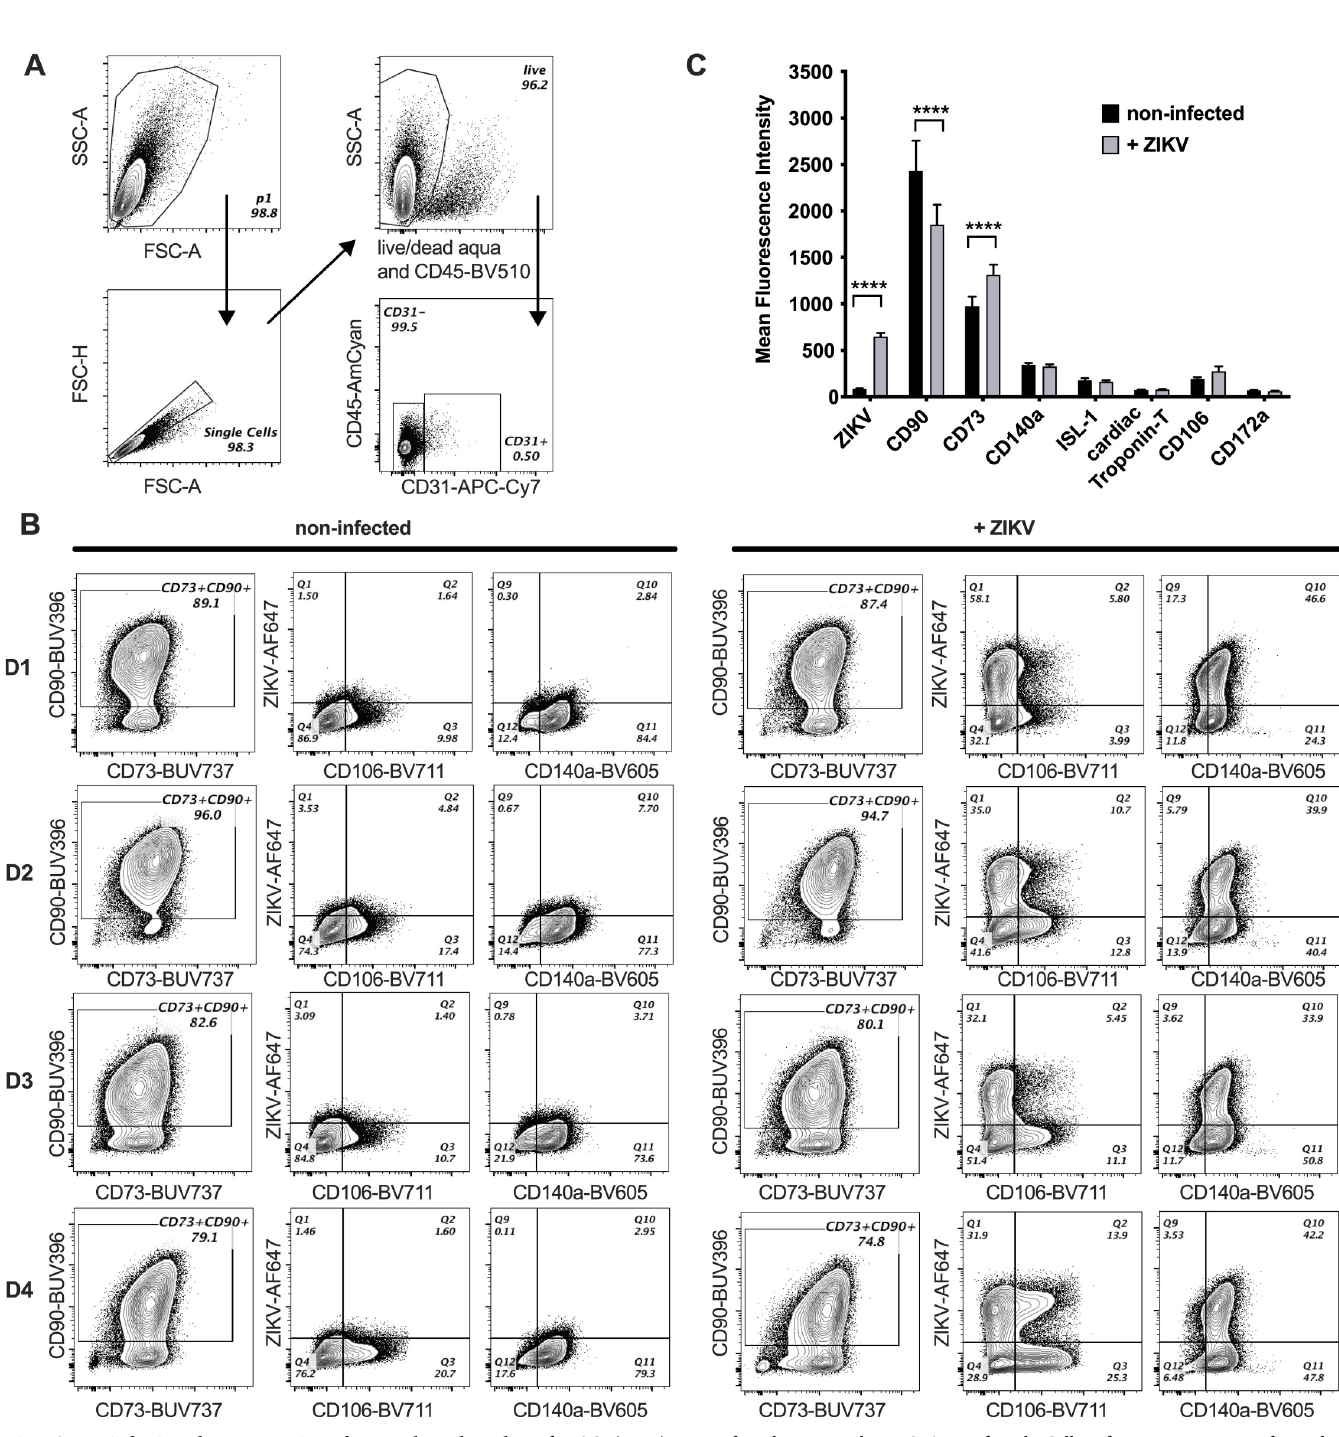
Fig 2. ZIKV infection alters expression of mesenchymal markers. fcMSCs (n = 4) were infected or not with 1 MOI ZIKV for 6 h. Cell surface staining was performed 48 h post-infection using antibodies against CD31, CD45, CD73, CD90, CD106, CD140a and CD172a; and intracellular staining with 4G2 antibody (for ZIKV detection), ISL-1, and cardiac Troponin-T. (A) fcMSCs were selected for their size (FSC vs SSC), viability, and subsequently CD45 − CD31 − cells were used to assess expression of selected markers. (B) Flow cytometry assessment of indicated markers expression, with and without ZIKV infection. Mean MFI of all markers for all donors tested are plotted with error bars indicating SEM. D1—D4: donors 1–4. (C) Bar graphs depicting mean fluorescence intensity (MFI) for different markers in ZIKV infected cells (grey bars) or non-infected controls (black bars) with ZIKV as indicated.